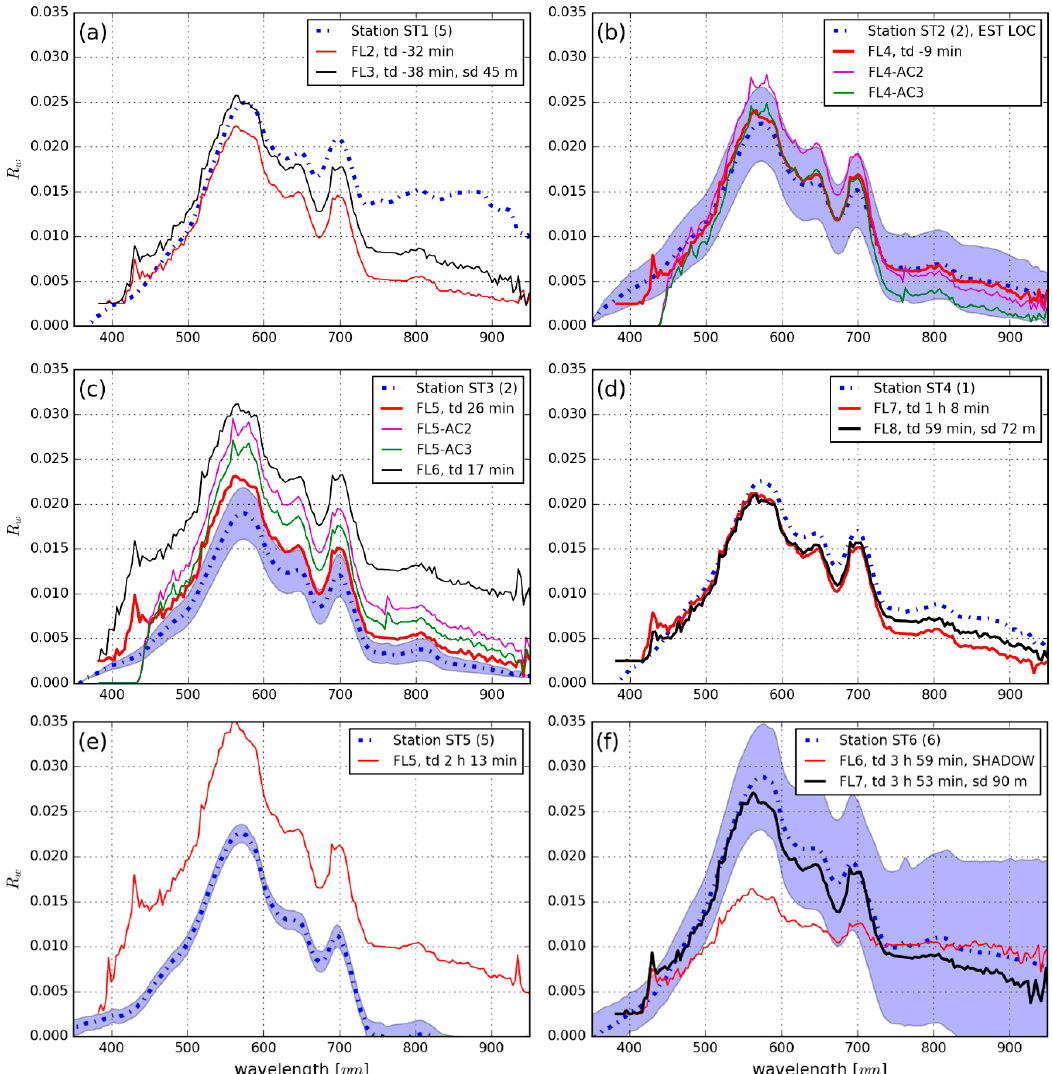
Figure 4. ( a – f ) In situ station and image-derived R w of each matchup. The best matchups in terms of Chi-square and spectral angle are shown in a thicker line in panels ( b – d , f ); Image R w from atmospheric correction strategies AC2 and AC3 are included in panels ( b , c ); Bracketed values in the panel legends state the number of spectra used to calculate the in situ spectrum and error bars; td = time difference between in situ measurement and image acquisition, sd = distance between in situ and image matchup measurement, if applicable. Standard deviations for the in situ station measurements are plotted as error bars (blue shading) where available.